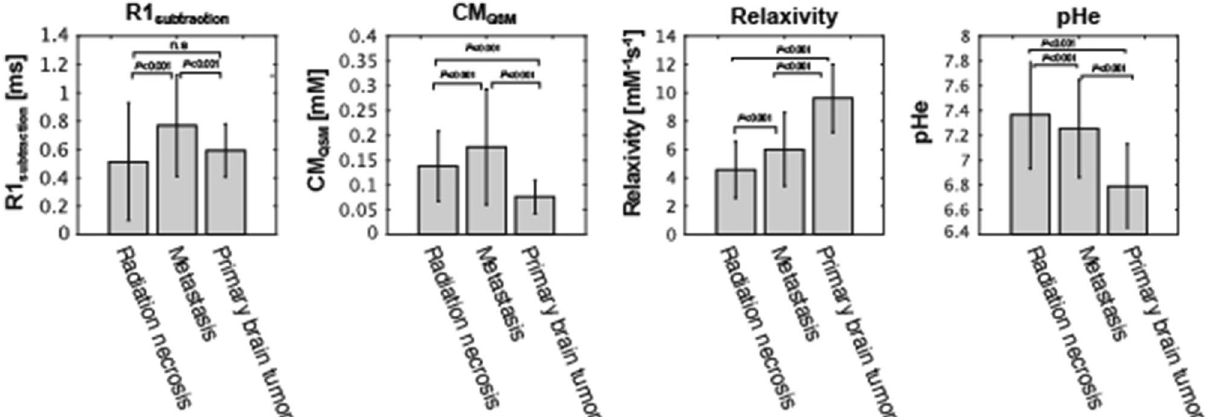
Figure 5. Mean R1 subtraction, CA qsm , relaxivity, and pHe values among patient groups. The mean pHe value showed a trend for tumor malignancy having a lower pHe value and primary brain tumors having a significantly lower pHe than other brain diseases ( P < 0.001).